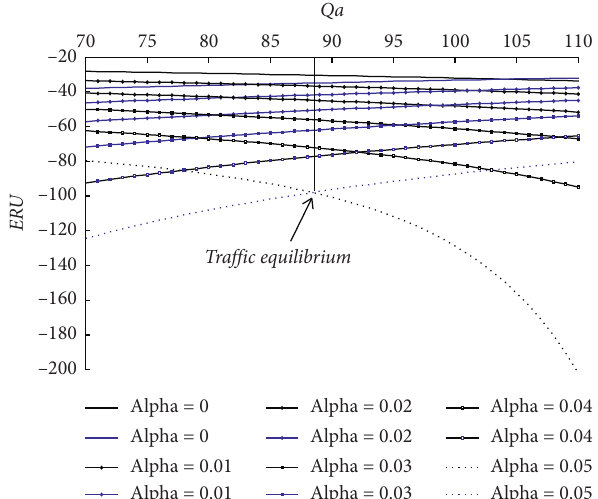
Figure 5: Influence of risk aversion parameter on traffic equilib- rium. Note: the black line denotes route a , and the blue line denotes route b .